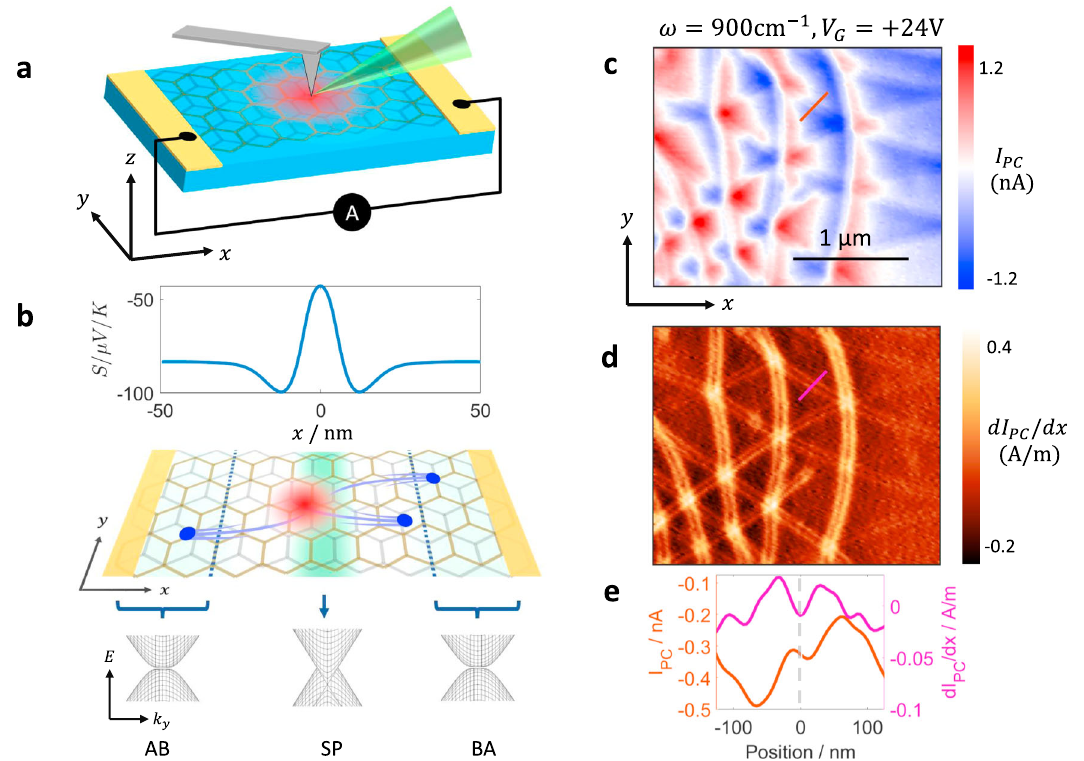
Fig. 1 Photocurrent in minimally twisted bilayer graphene. a A schematic of scanning photocurrent setup. The red region represents the hot carriers generated under the tip. b Top: Seebeck coef fi cient S pro fi le across a domain wall calculated from fi rst principles (Supplementary Note 3). The DW is located at x = 0. Middle: perspective view of the experiment showing photocurrent generation at the domain wall. The green background represents the Seebeck coef fi cient pro fi le and the blue dots represent carriers generated by thermoelectric effect. Bottom: schematic of the BLG band structure across the DW for three different stackings AB, BA, and saddle point (SP). c Photocurrent ( I PC ) image taken with ω = 900 cm − 1 and V G ¼ þ 24V at T ¼ 300K. d Spatial gradient of the photocurrent de fi ned as d I PC /d x of the data in c . e Line pro fi les of I PC and d I PC /d x across a DW (shown as red and magenta lines in c and d